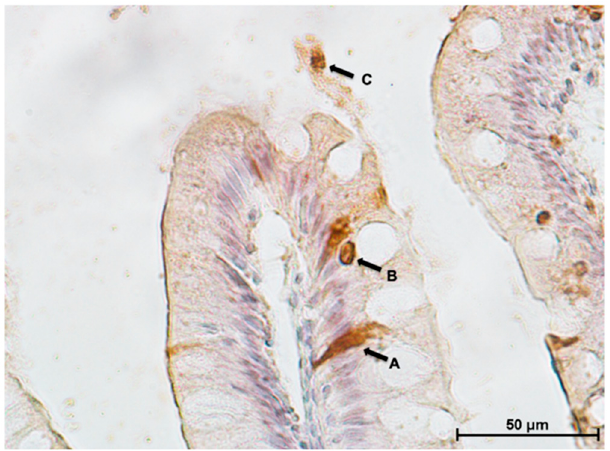
Figure 18. In situ detection of cells undergoing apoptosis showing three different apoptotic stages: A: early apoptotic stage; B: apoptotic body: C: cells exfoliating into the intestinal lumen. Overall, proliferation, di ff erentiation and apoptotic rate were not homogenously distributed